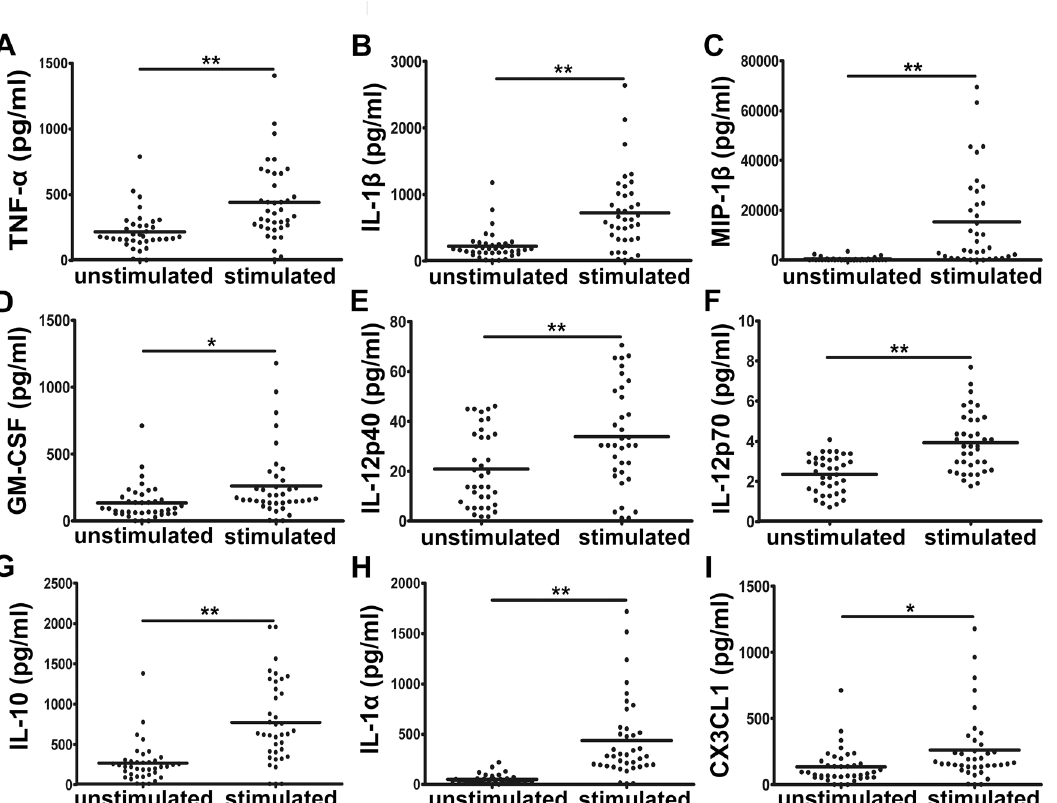
Fig 3. Cytokine/chemokine levels in PBMCs from BCG-vaccinated healthy donors (BHD), with or without ESAT-6 stimulation. The levels of (A) TNF- α , (B) IL-1 β , (C) MIP-1 β , (D) GM-CSF, (E) IL-12p40, (F) IL-12p70, (G) IL-10, (H) IL-1 α , and (I) CX3CL1 are shown. * P < 0.05, ** P < 0.001. P : P value. An independent-sample T test was performed.